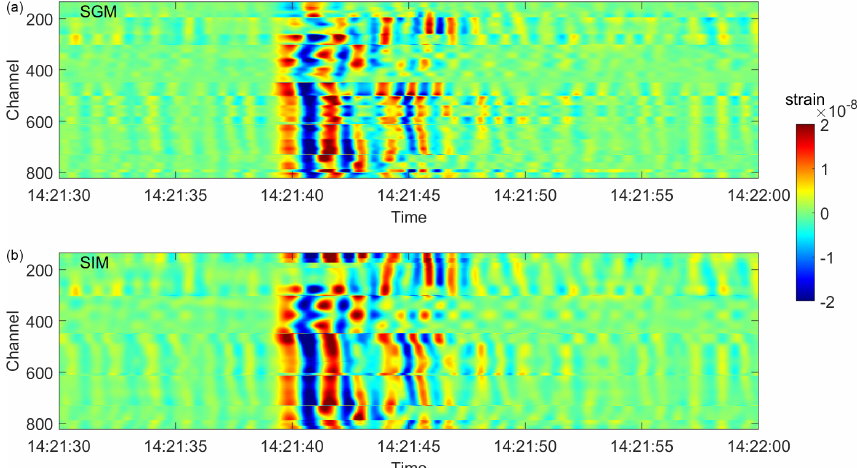
Figure 8. Strain estimates over all fibre channels using SGM (a) and SIM (b) for the LP event. The solutions with the minimum RMSE are chosen, respectively (Fig.